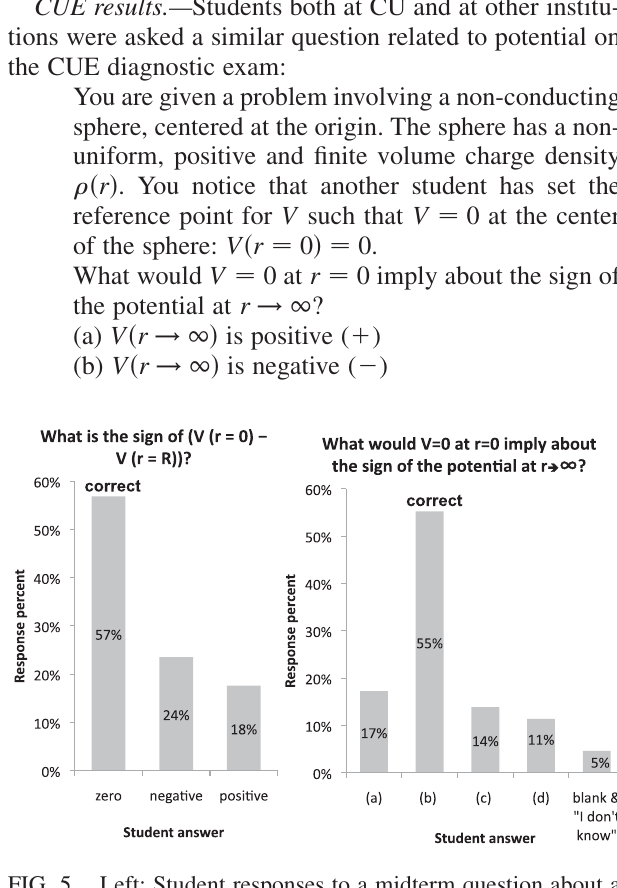
FIG. 5. Left: Student responses to a midterm question about a thin shell of uniform charge. Not included in this graph is one student whose answer was unclear. N ¼ 51 . Right: Student responses to the CUE question about potential described in the text. N ¼ 324